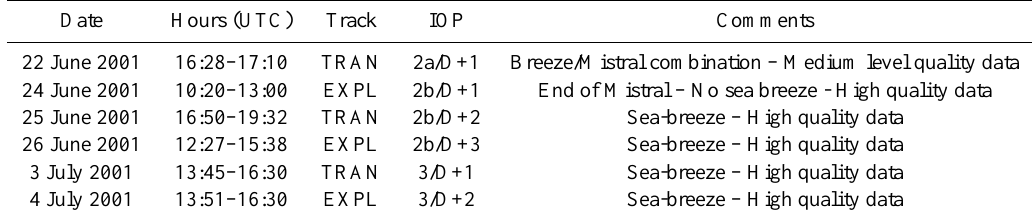
Fig. 2. The two typical flight tracks of the DLR Flacon 20 carrying the Doppler lidar WIND on board. Flight track of panel a is called ”transect track” (hereafter denoted track TRAN); flight track of panel b is called ”exploration track” (hereafter denoted track EXPL). The topography is shaded in grey when higher than 500 m above sea level. Table 1. Scientific flights during ESCOMPTE. TRAN and EXPL correspond to typical flight tracks. Tracks TRAN (for “transect” track) and EXPL (for “exploration” tack) are shown in Fig.